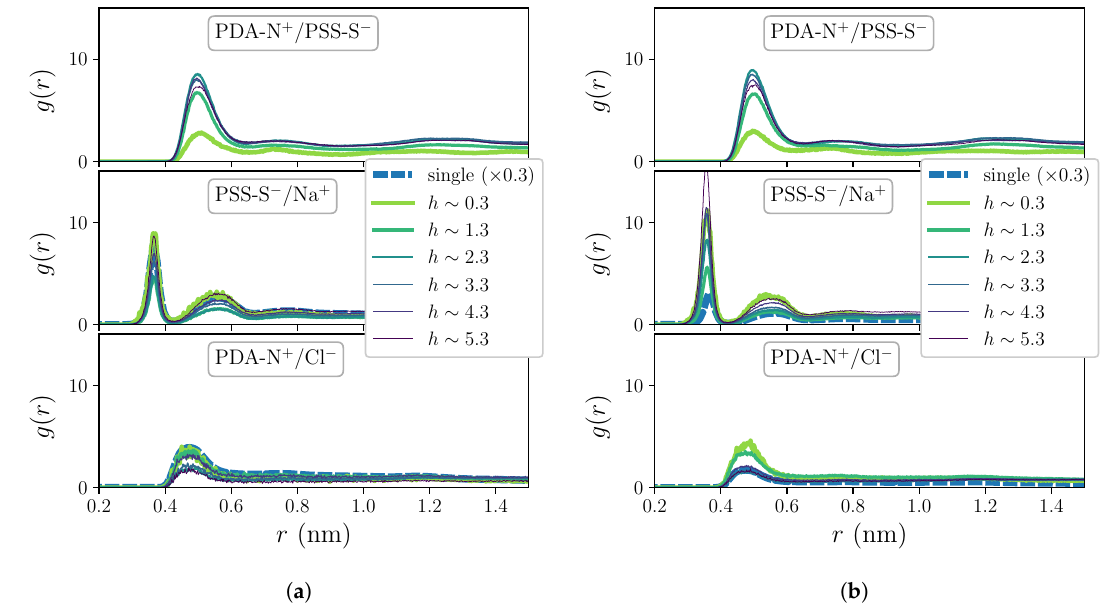
Figure 3. Selected RDFs for polyions charge pairings corresponding to systems under non-zero added salt concentration conditions: c = 0.1 M ( a ) and c = 0.5 M ( b